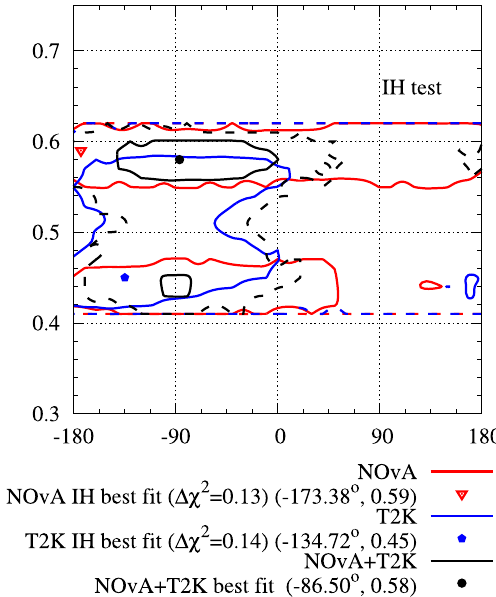
analysis of both. The solid (dashed) lines indicate the 1 σ (3 σ ) allowed regions. The minimum χ 2 for NO ν A (T2K) with 50 (88) bins is 47.71 (93.14) and it occurs at NH. For the combined analysis, the minimum χ 2 with 138 bins is